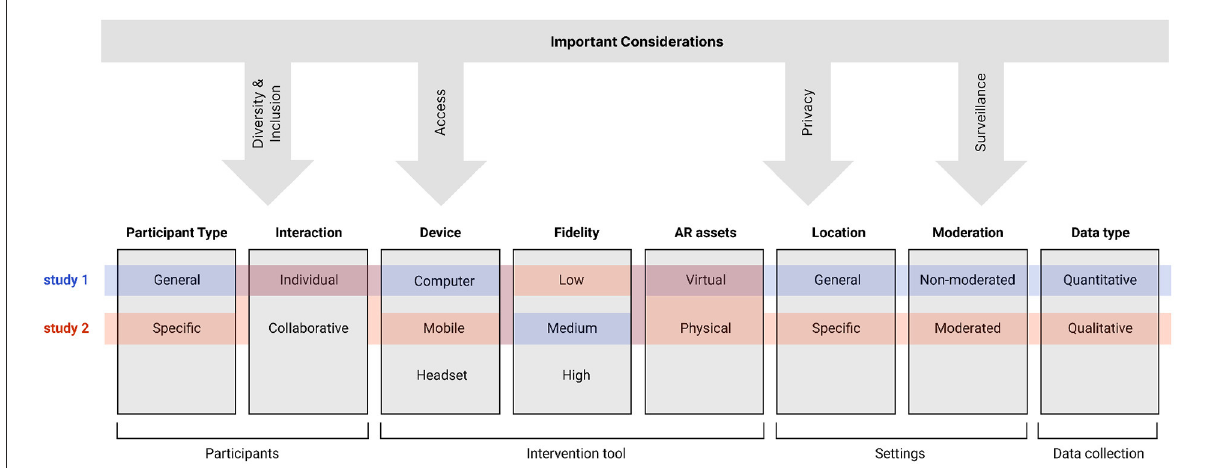
FIGURE6 The DiCRAs Framework: Illustration of remote AR studies’ design space configurations for the two presented studies. This illustration depicts the difference between the two studies across a number of attributes considered when characterizing remote AR interventions: Participant type, Interaction, Device, Fidelity, AR assets, Location, Moderation, and Data type. Such a framework allows researchers to consider where their work and impact are in the field of remote AR design and evaluation and consider what strategies might be best for their specific